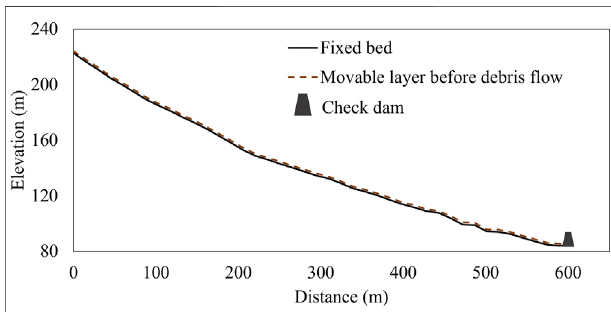
FIGURE 3 | Hydrograph of simulated debris fl ow